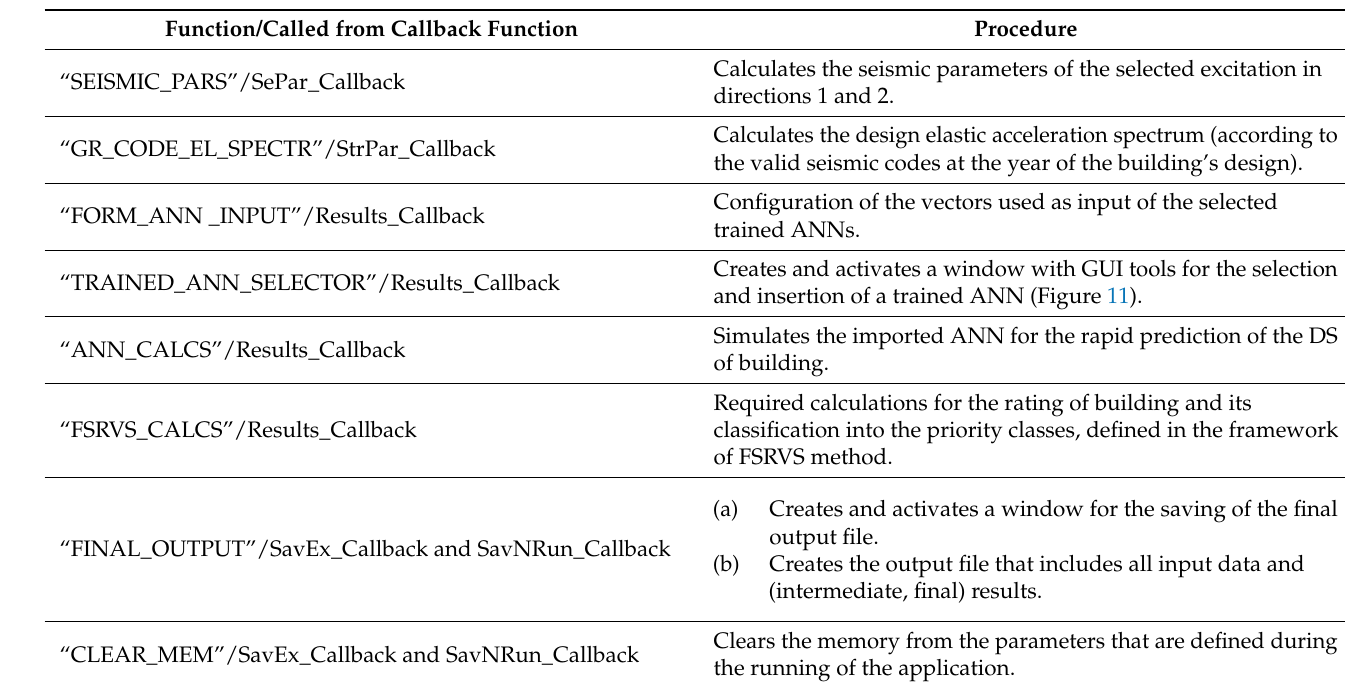
Table 5. Description of the external functions of the